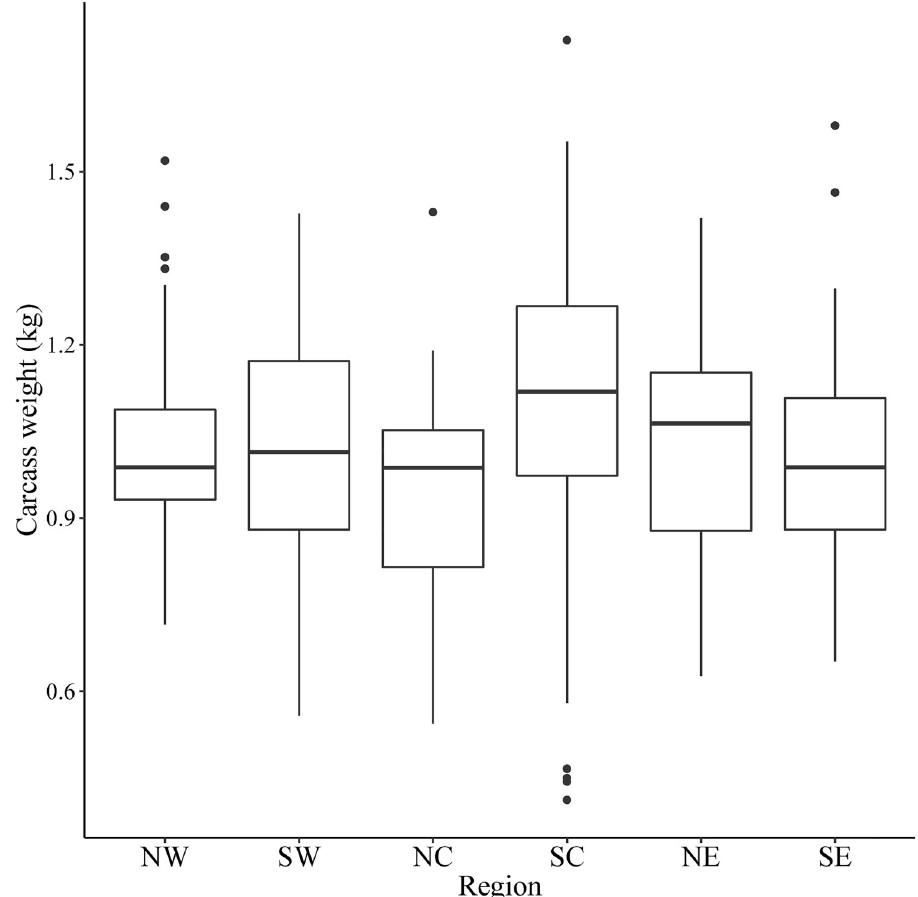
Fig 3. Muskrat ( Ondatra zibethicus ) carcass weight (kg) in each region in Pennsylvania, USA, 2018–2019 (NW-Northwest, SW-Southwest, NC-Northcentral, SC-Southcentral, NE-Northeast, SE-Southeast).